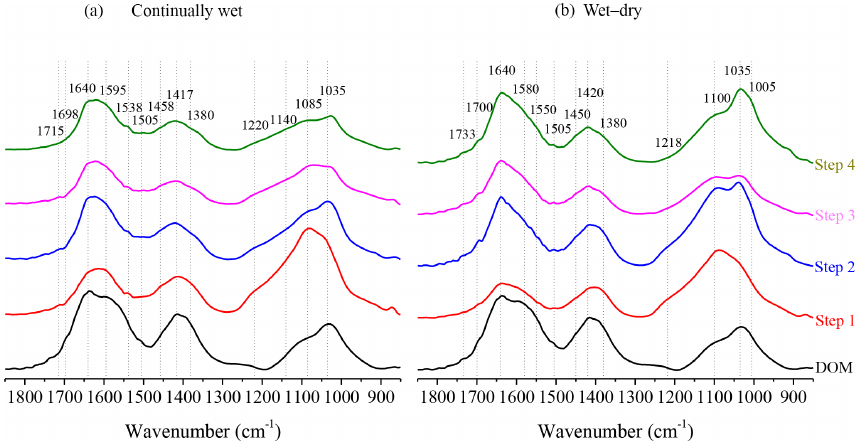
Figure 3. Transmission FTIR spectra of the dried DOM solution reacted with JRB soils from steps 1 to 4 for continuously wet (a) and wet–dry cycles (b) and the unreacted JRB DOM solution (bottom black line). For color rendering of this image please refer to the online version.